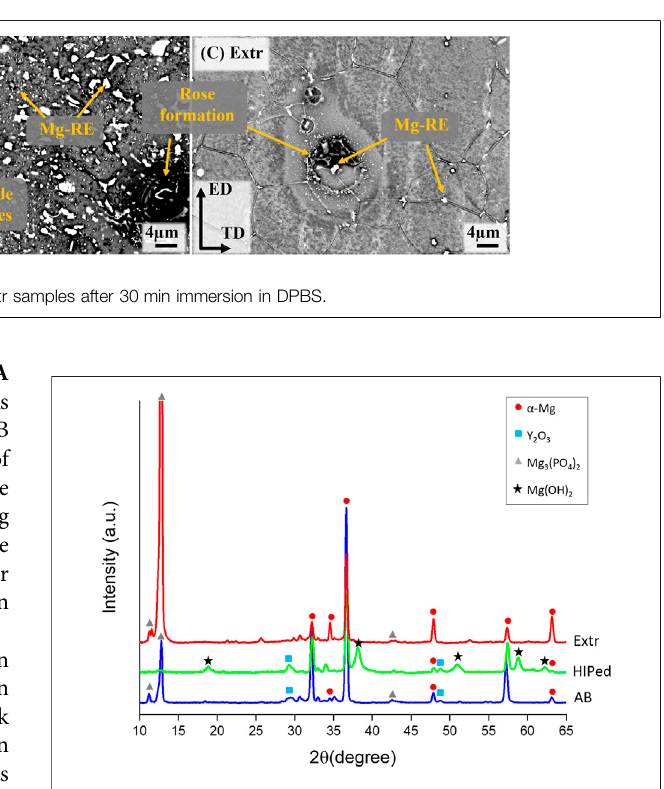
FIGURE11| XRDoftheBDsurfacesoftheABandHIPsamples,aswell as the Extr samples after 28 days of immersion in